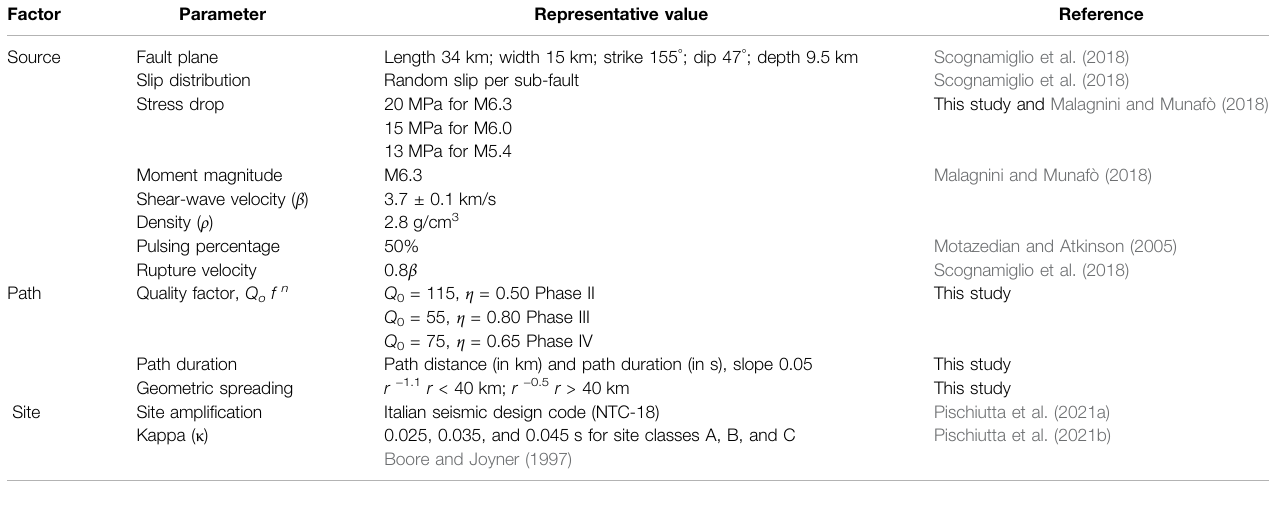
TABLE 2 | Model parameters for the fi nite-fault simulation of the 30 October 2016, M6.3 Norcia Italy earthquake.